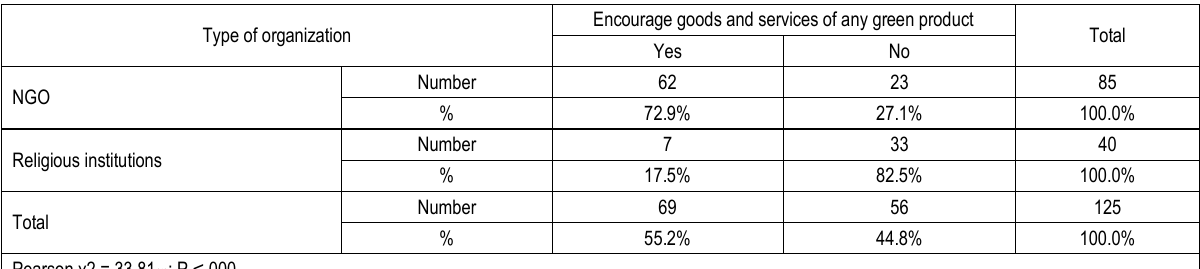
Table 4. Connotation between the type of institutions and encouraging goods and services of any green product in Bangladesh